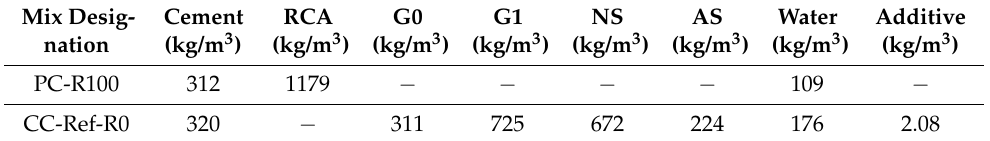
Table 3. Mixture proportions of studied